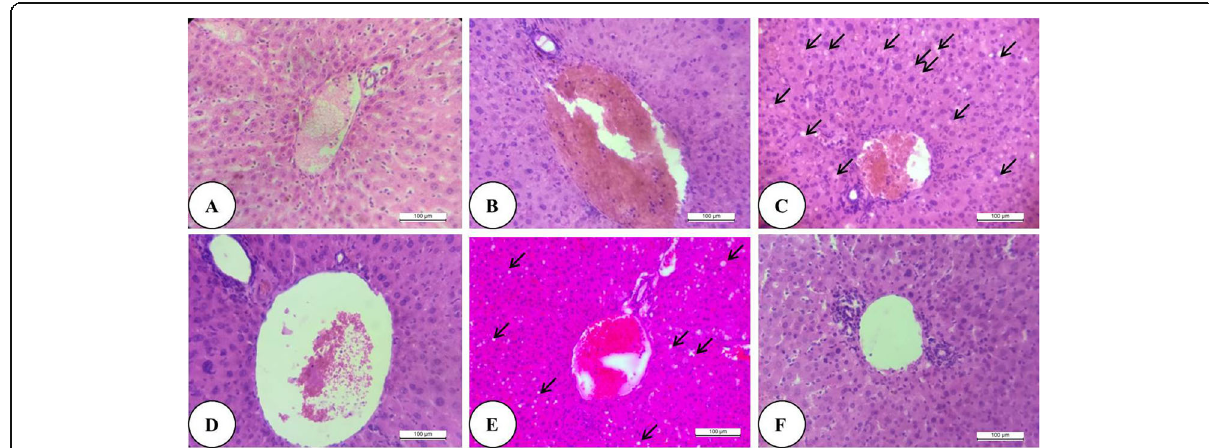
Fig. 8 Histopathology of liver tissue sections stained with hematoxylin and eosin. A NC group and B PC group shows normal liver histology with central vein and hepatocytes. C IRN group low-grade NAFLD in the form of fat accumulation in the liver tissue in the 12-week study period. D GT group showing normal liver histology. E IRN+GT Low group showing decrease in fat accumulation as compared to the IRN group. F IRN+GT High group showing normal liver histopathology without NAFLD. (Arrow head represents area with fat accumulation)